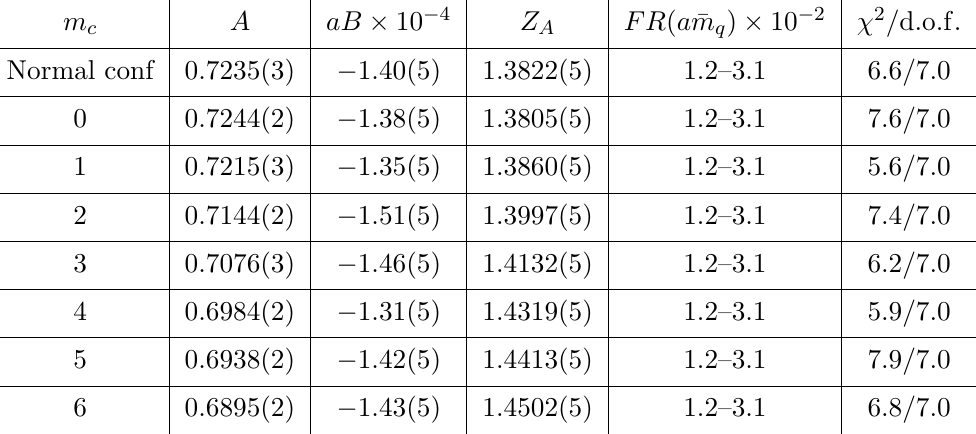
Table 11 . The (cid:12)tting results of slope A and intercept aB obtained by (cid:12)tting the function a(cid:26) = Aa (cid:22) m q + aB . The numerical results of the renormalization constants Z A